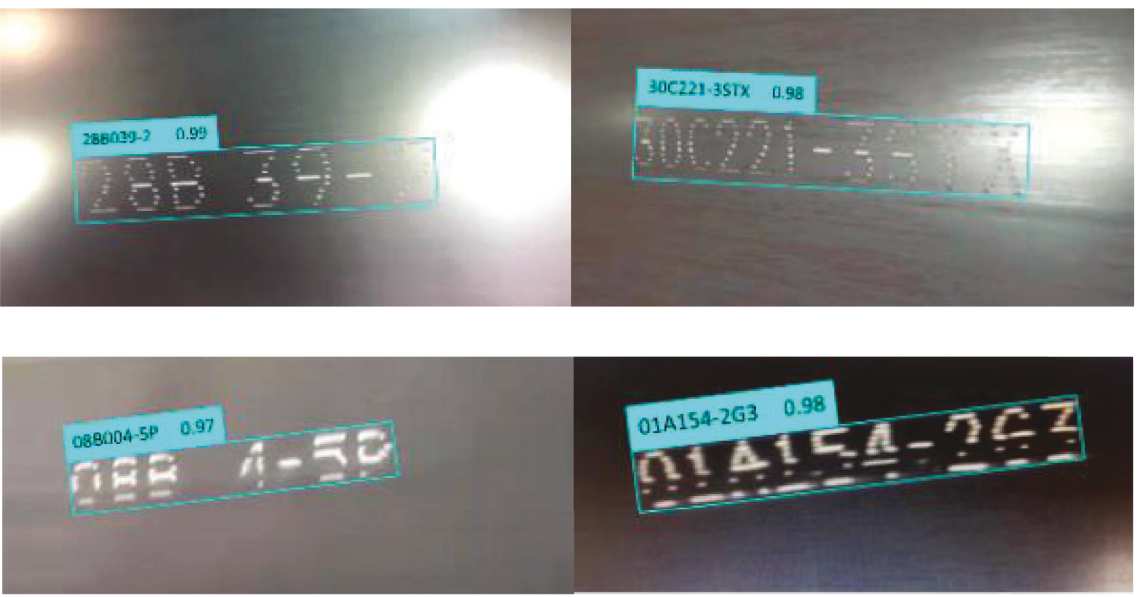
Figure 6: Detection and identification results of nonstandard thermal inkjet